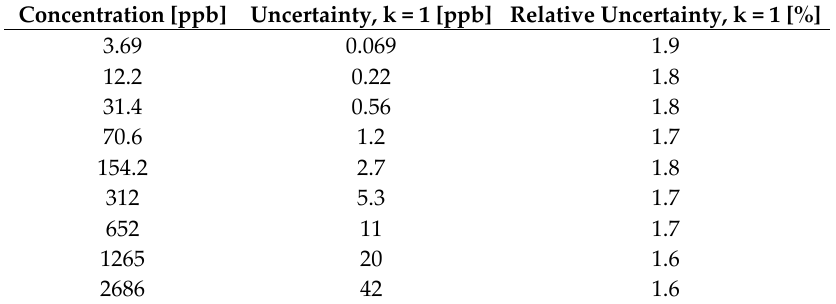
Table 1. Calculated NO 2 concentrations and uncertainties in parts per billion (ppb) and percent (%).